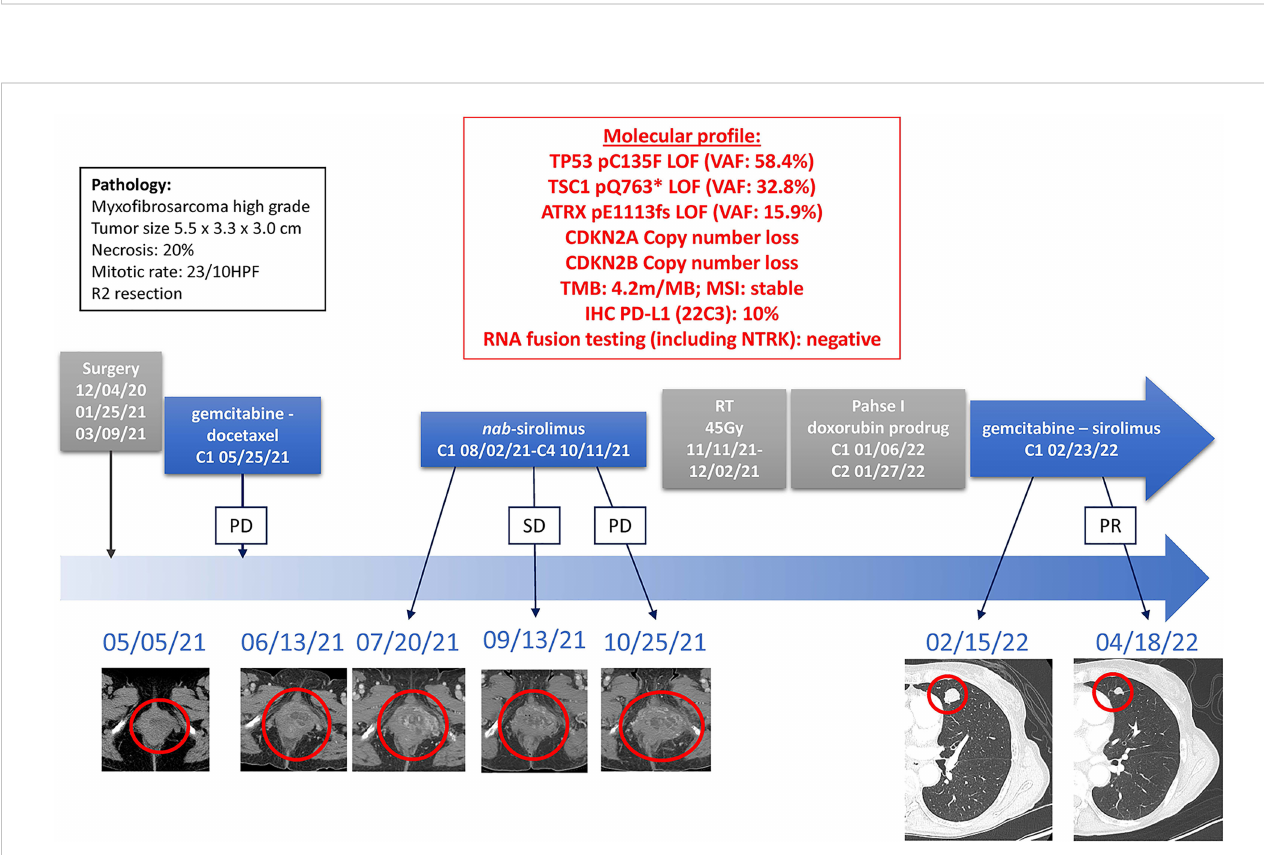
FIGURE 4 Timeline of Treatments of Patient 2. Treatment lines are displayed chronologically, with imaging assessments at baseline, at time of best response to treatment, and at time of end of treatment for each line of treatment. Initial pathology diagnostic and molecular pro fi les are displayed. HPF, high power fi eld; IHC, immunohistochemistry; LOF, loss-of-function; MSI, microsatellite instable; PD, Progressive Disease; PR, Partial Response; SD, Stable Disease; TMB, tumor mutational burden; VAF, variant allele fraction